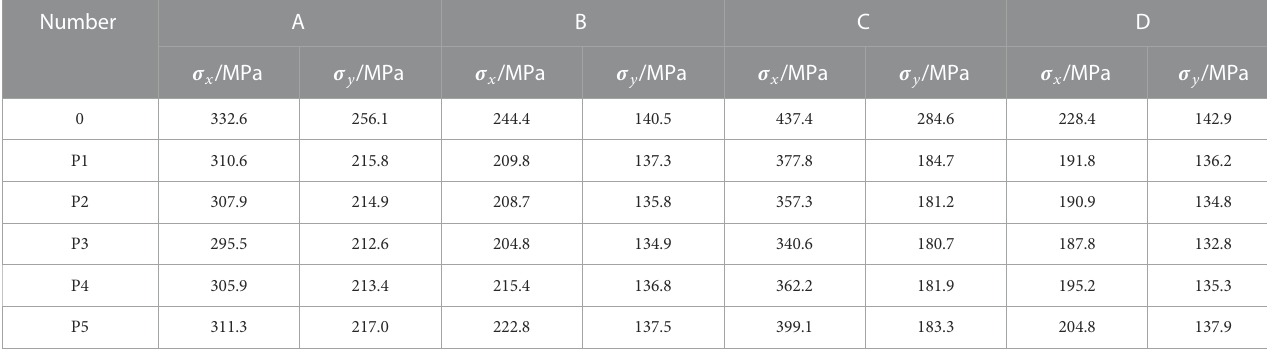
TABLE 4 Residual stress under different ultrasonic